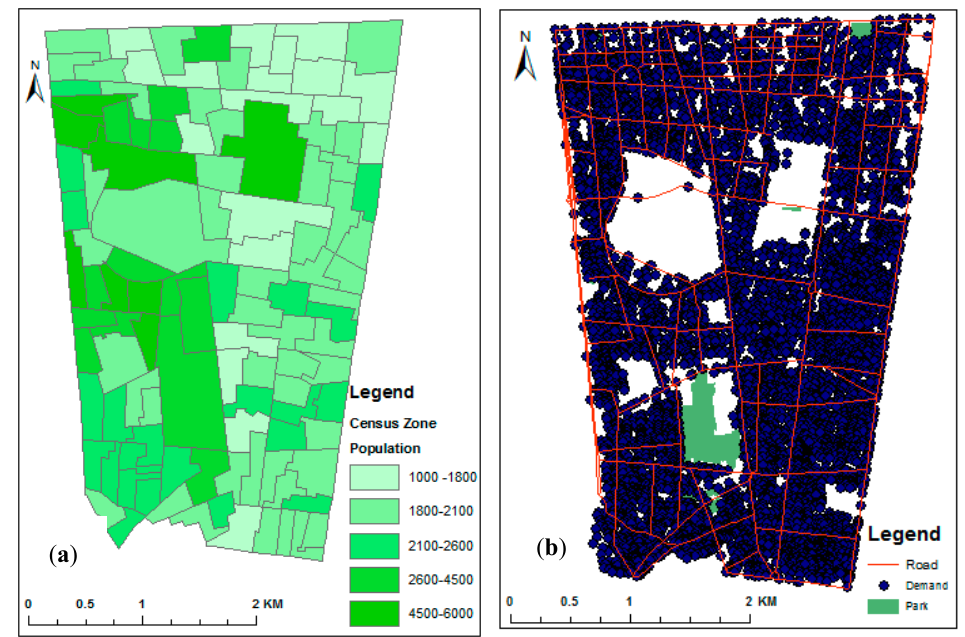
Figure 2. ( a ) The populations of each census zone in region 11, Tehran; ( b ) The distributed demand points.